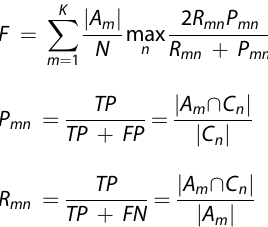
Figure 5b – i is the 2D MDS results for four selected patterns on the Euclidean, Manhattan, cosine, Pearson, JSD, EMD, DTW, and NC-DTW measures, respectively. The better dissimilarity measures result in the s olid-blue and dotted-blue patterns appearing closer due to similar structural phase (bcc), while the distance between the different structure phases should be large. On the 2D MMDS mapping in the Euclidean, Manhattan, EMD, and DTW the distance between the solid-blue and dotted-blue is large in spite of the fact that they are from the same structural phase because these measures are strongly affected by the peak intensity difference. On the other hand, the cosine, Pearson, and JSD dissimilarities allow us to locate same structural phases closer in the 2D MMDS mapping since they mainly judge the peak shape, not peak